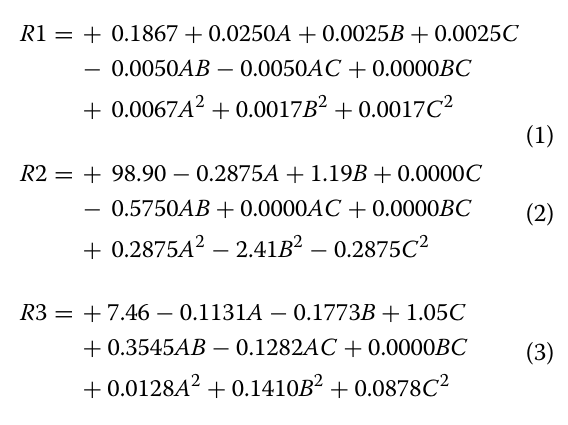
1: High level (10 mg) +